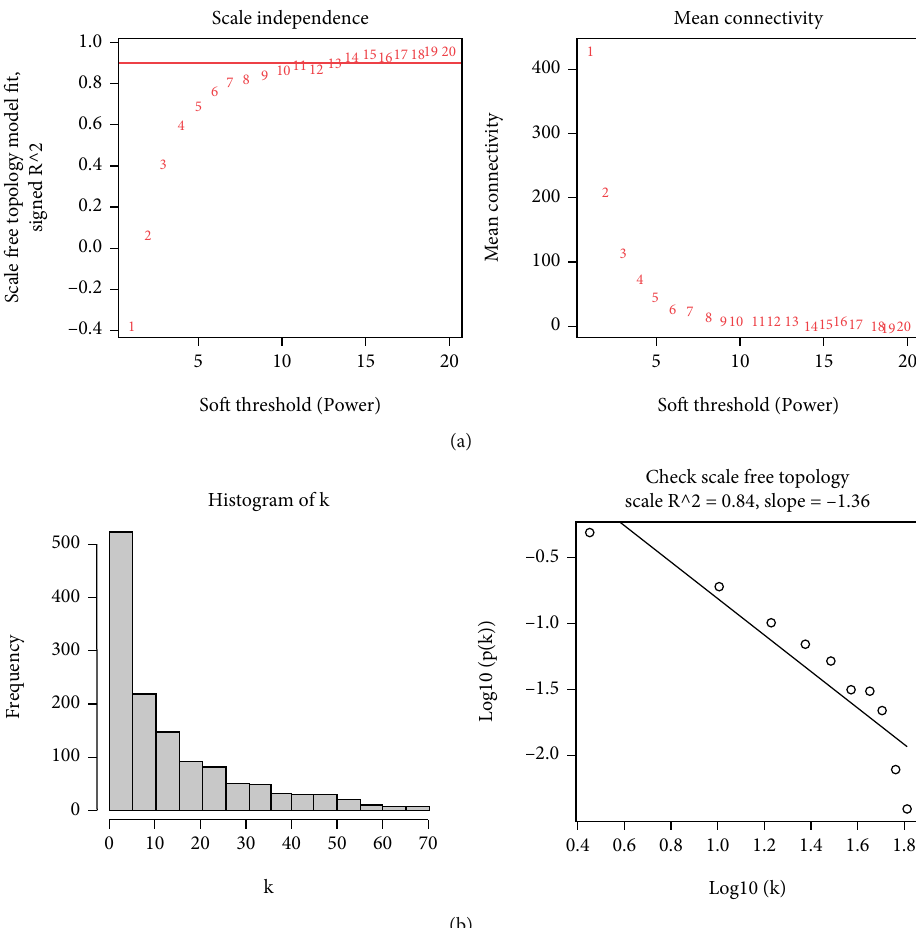
Figure 1: Estimating the soft-thresholding power in the WGCNA. (a) Analysis of a scale-free fi t index and average connectivity for di ff erent soft-thresholding values ( β ). The red line denotes the region where the correlation coe ffi cient is 0.9, and the respective soft-thresholding power is derived using the R software as 9. (b) Histogram indicating the connectivity distribution and determining the scale-free topology if β = 9